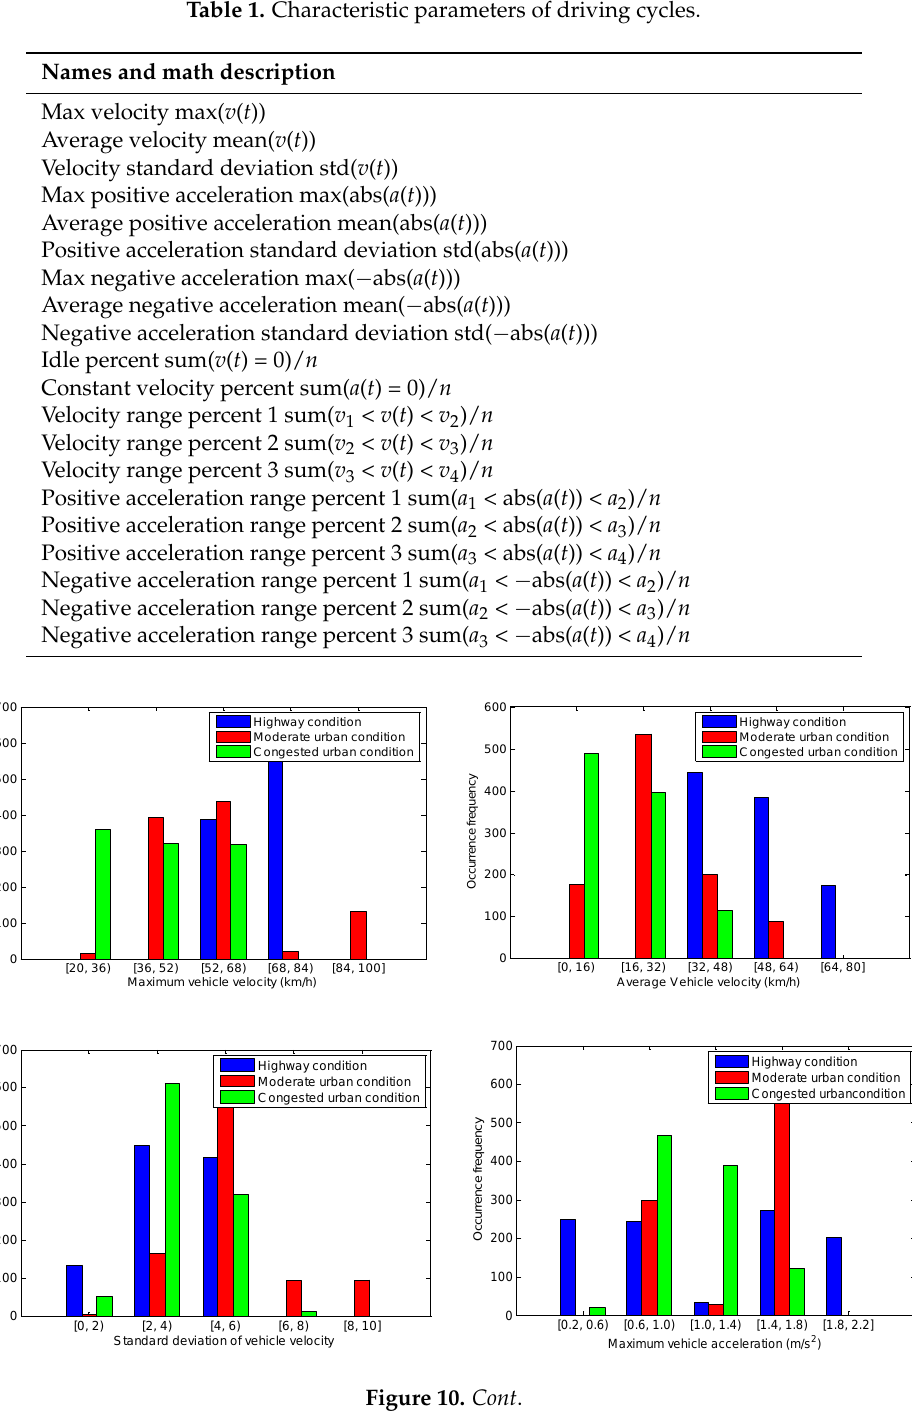
Table 1. Characteristic parameters of driving cycles.